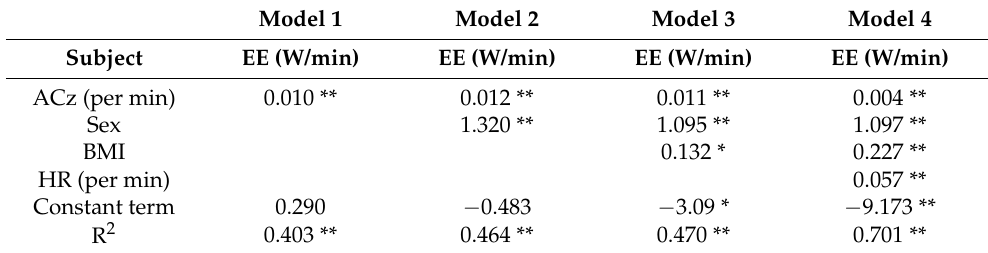
Table 4. Energy consumption model (based on ACz).